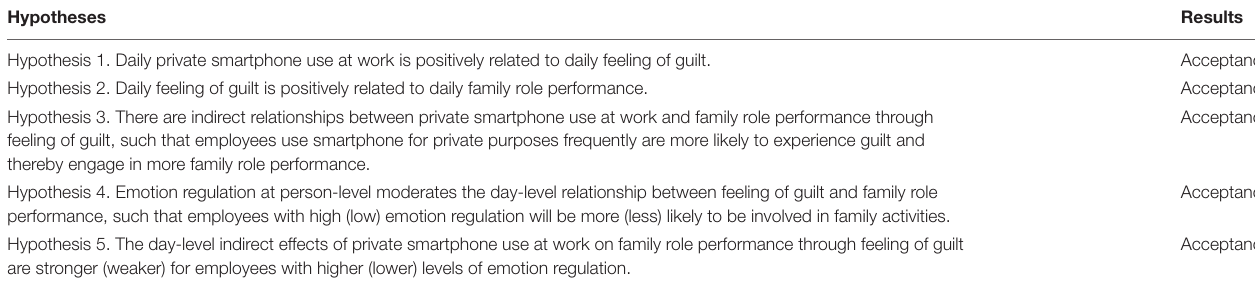
TABLE 3 | Results for hypotheses testing.